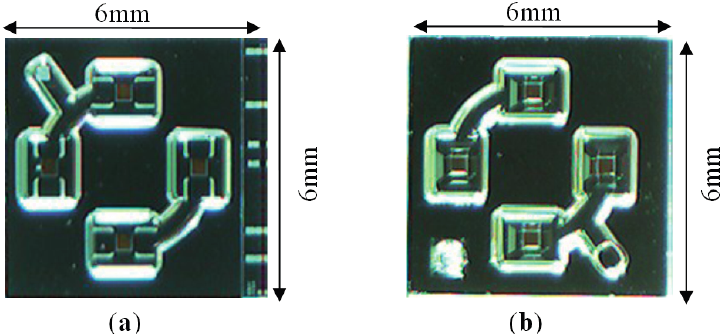
Figure 11. Microphotographs of the gyroscopic sensor structure. ( a ) Top view of the gyro; ( b ) Bottom view of the gyro.